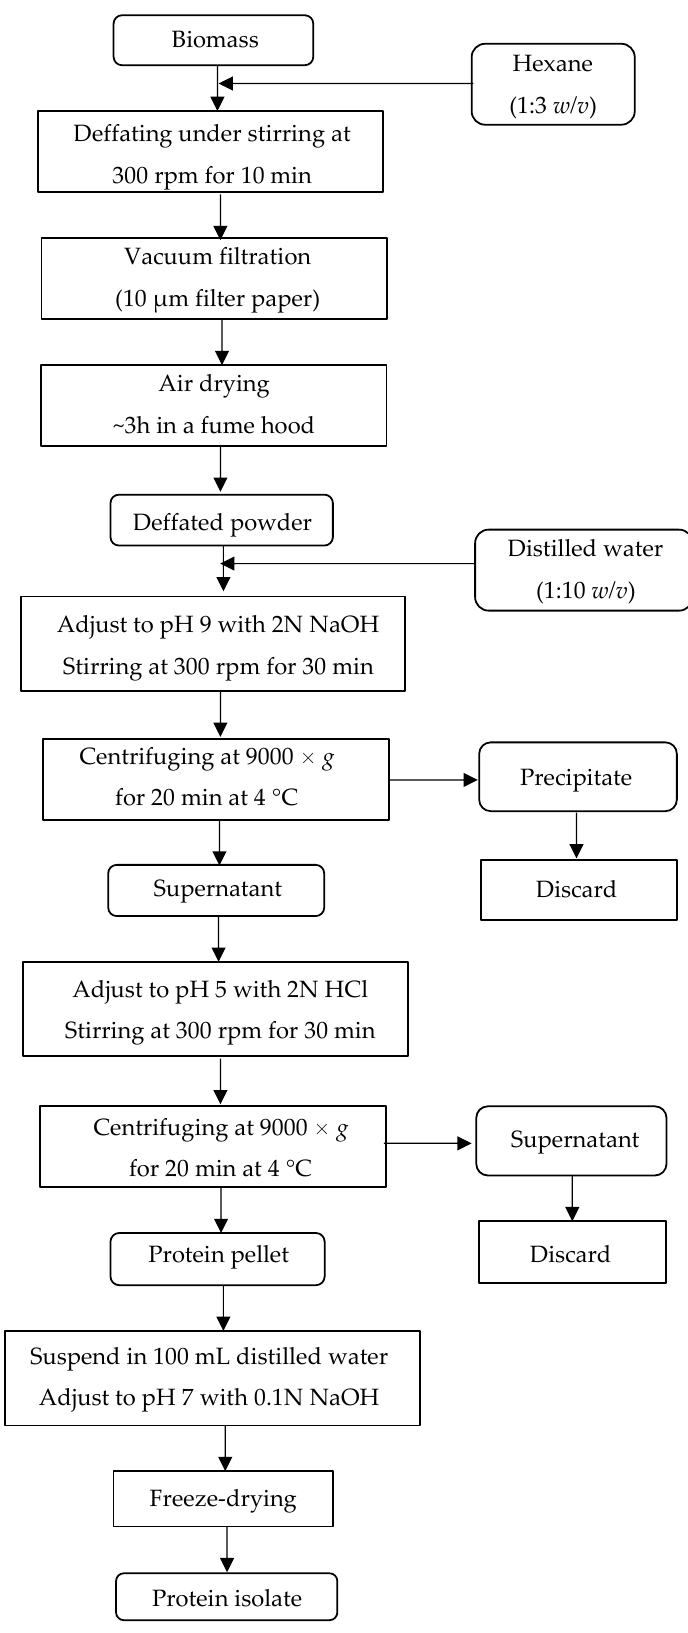
Figure 2. Steps for protein extraction by alkaline extraction/isoelectric Figure 2 . Steps for protein extraction by alkaline extraction/isoelectric precipitation.